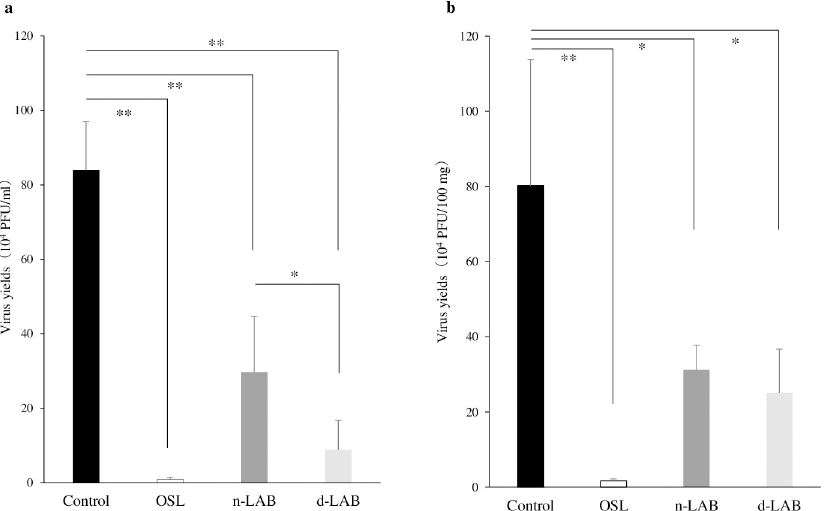
Fig 6. Effect of LAB or d-LAB administration on viral load in mice. Virus yield in BALF ( a ) and lung samples ( b ) were measured using a plaque assay on day 3 post-infection. Each value is presented as the mean ± SD; n = 5; �� p < 0.01; � p < 0.05. BALF, bronchoalveolar lavage fluid; d-LAB, dispersed lactic acid bacteria; n-LAB, non-treated lactic acid bacteria; OSL, oseltamivir; PFU, plaque-forming unit.